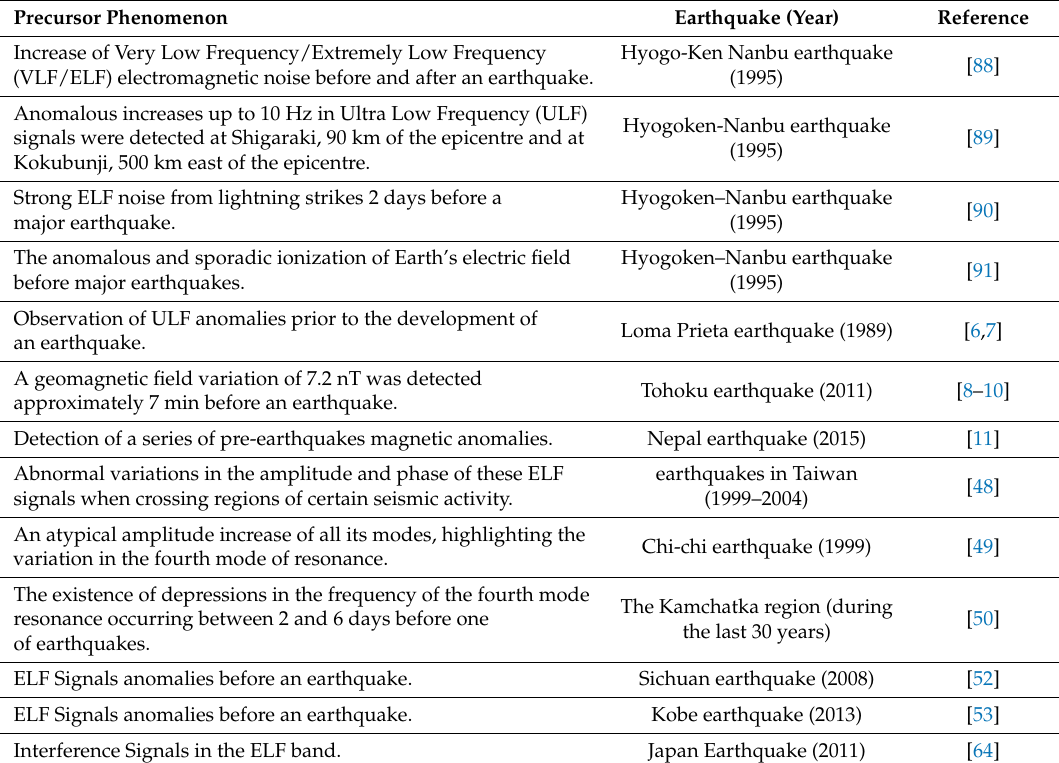
Table 4. Earthquake precursor